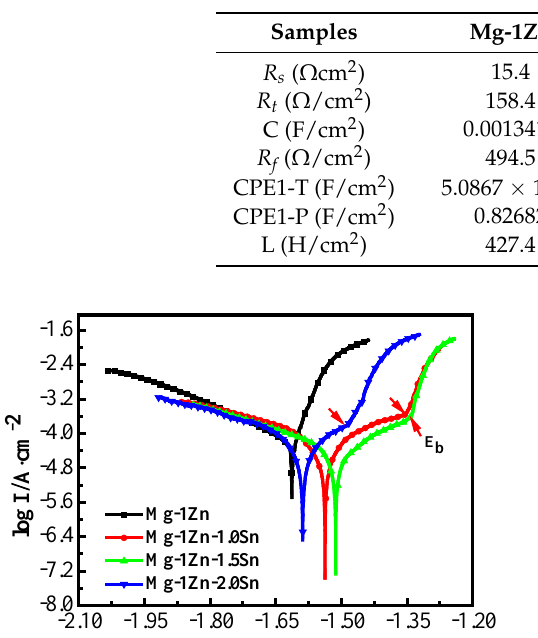
Table 5. Parameters of the circuit model fitted from the Nyquist plot.